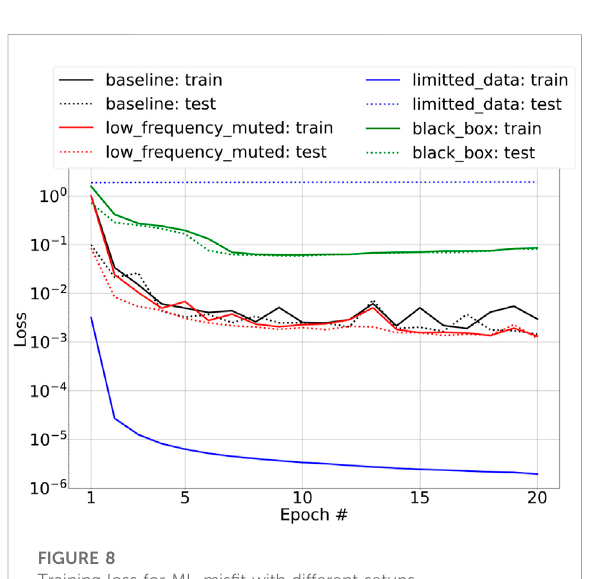
FIGURE 8 Training loss for ML-mis fi t with different setups.